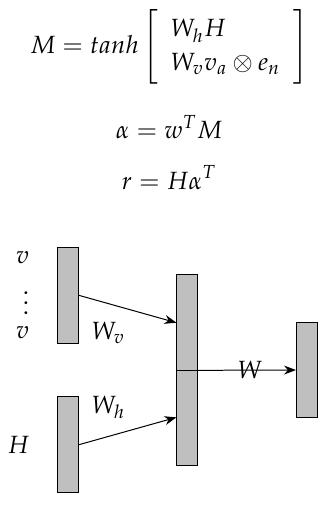
Figure 3. Architecture of attentive neural